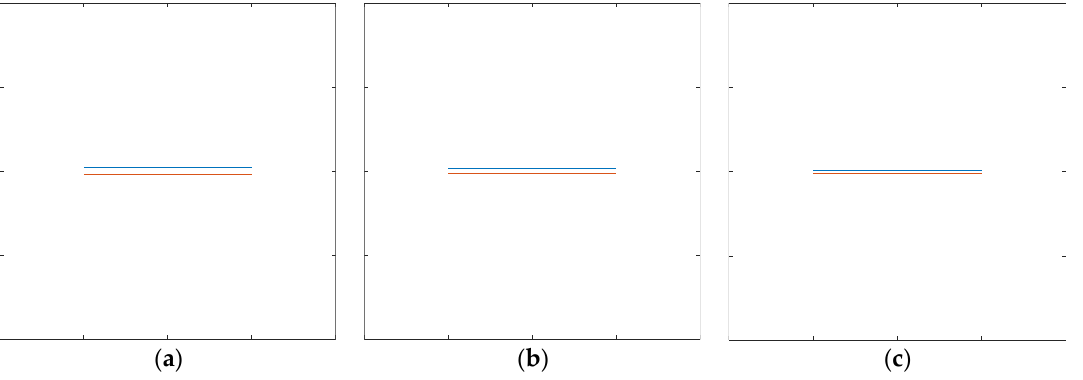
Figure 5. Double-line target location map. The distance between the two lines is ( a ) 0.4; ( b ) 0.3; ( c ) 0.2.